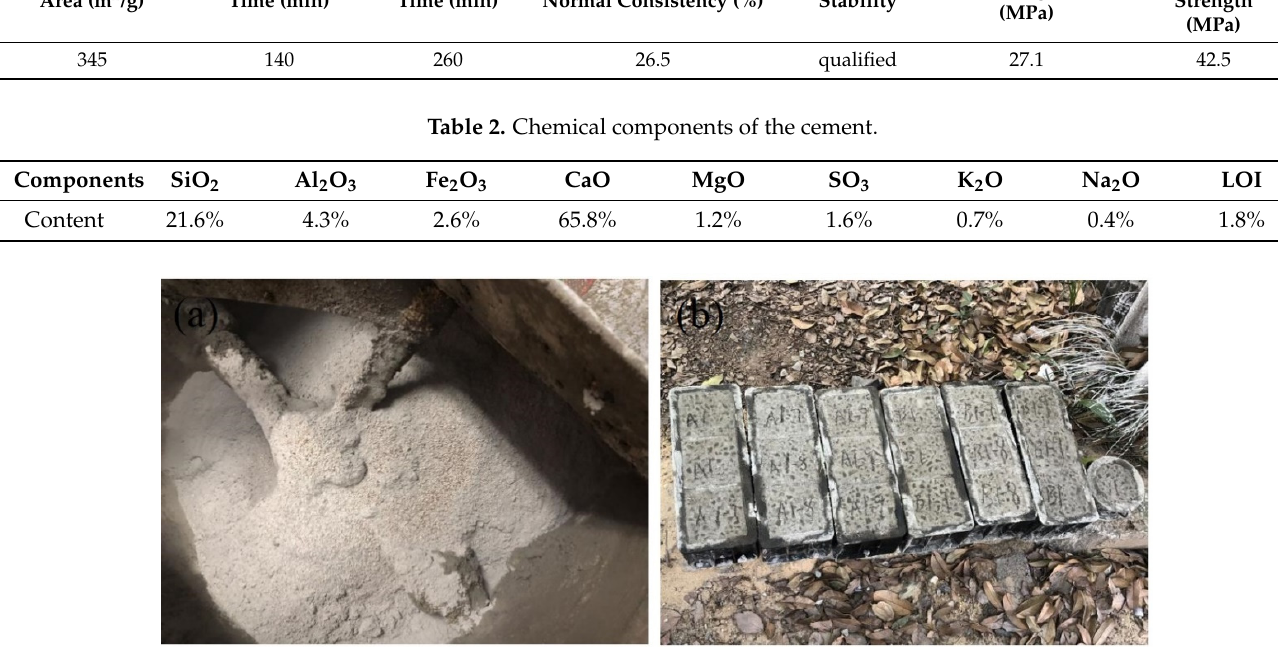
Figure 1. Preparation of the microencapsulated self-healing concrete cube specimens. ( a ) Adding the microcapsules. ( b ) Cube test piece before demolding.